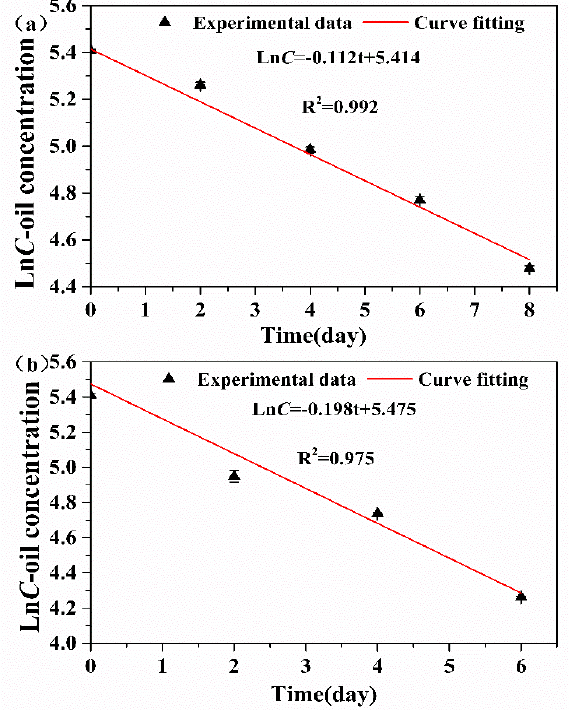
Figure 2. Heavy oil degradation kinetics of the ( a ) bacterial consortia and ( b ) laccase-bacterial consortia. Table 1. Degradation efficiencies of the bacterial consortia and laccase-bacterial consortia for C15 to C35 n-alkanes.